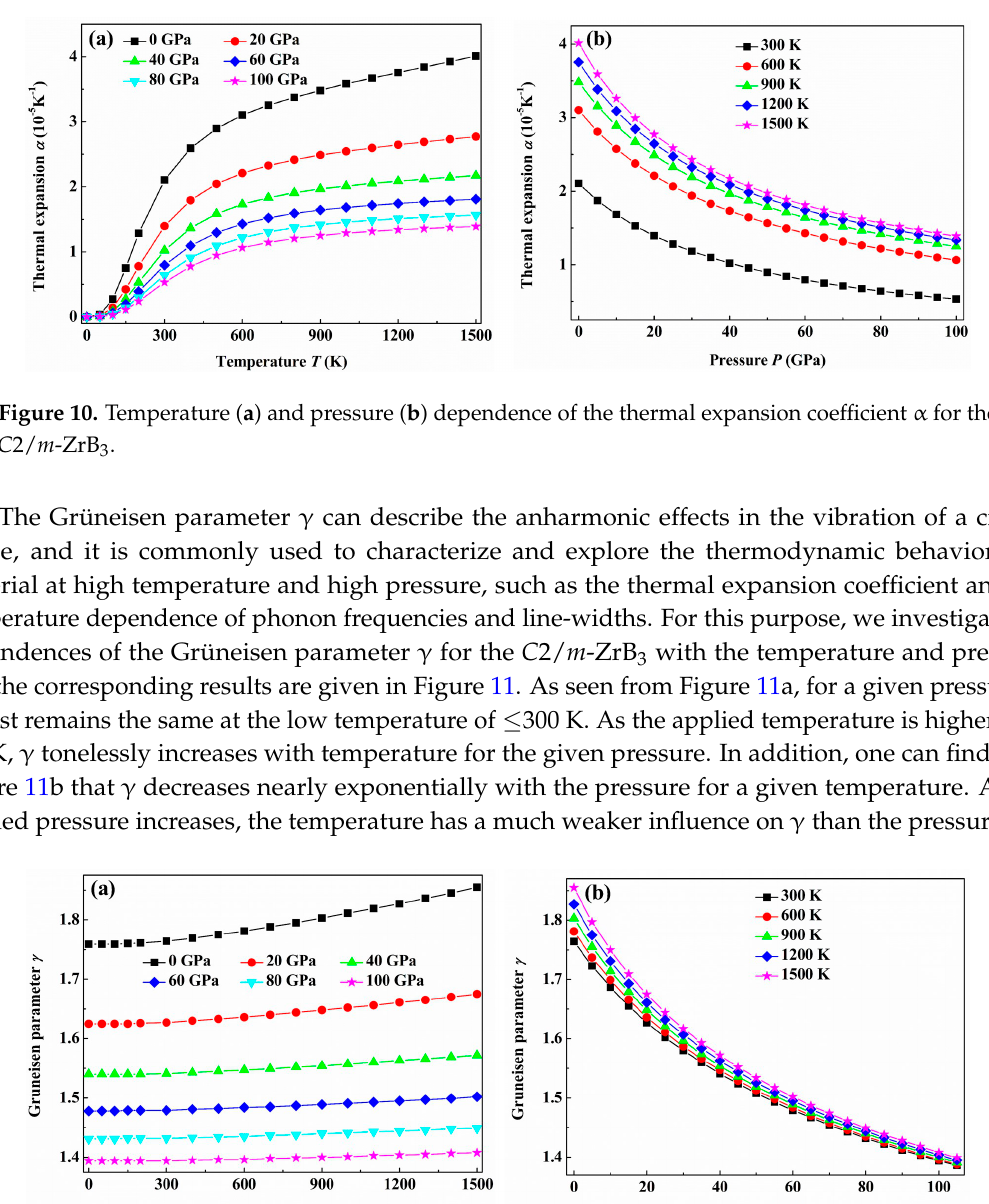
Figure 11. Temperature ( a ) and pressure ( b ) dependence of the Grüneisen parameter γ for the C 2/ m -ZrB 3